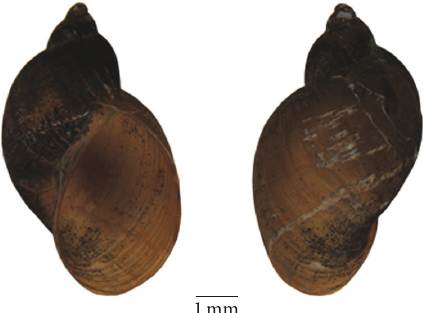
Figure 4: A picture of Lymnaea columella collected at study